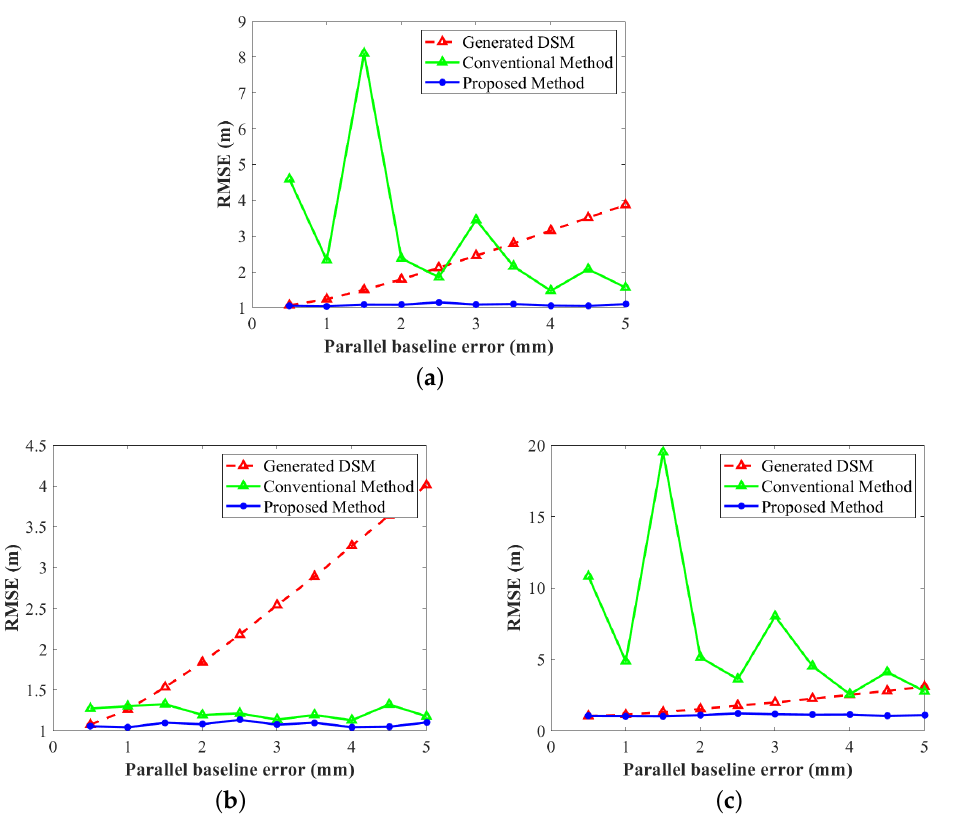
Figure 8. The RMSEs of the simulated experiment results. RMSEs of ( a ) the whole experimental area, ( b ) the controlled area, and ( c ) the uncontrolled